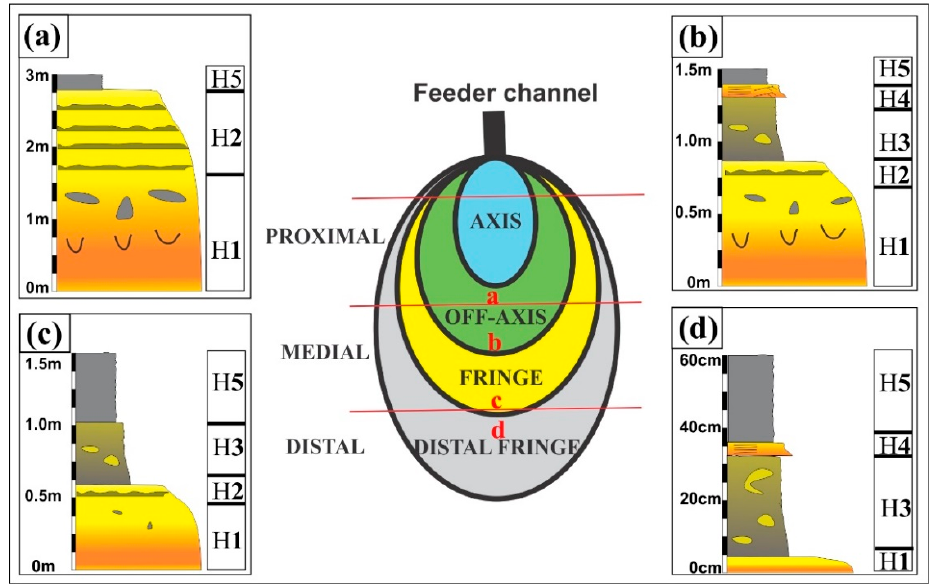
Figure 12. Distribution of hybrid facies from proximal to distal lobes. ( a ) Proximal lobes contain a major chunk of sands contained mainly H1 and H2 facies with thin caps of muds (H5). ( b ) A complete sequence of hybrid beds (H1 to H5) in a medial lobe. ( c ) Distal lobe in the fringe area contains small sandy hybrid event bed facies (H1–H2) but mainly comprises muddy upper facies of hybrid event bed. ( d ) The most distal part of lobe contains muddy hybrid event bed facies with total hybrid sequence less than one meter.